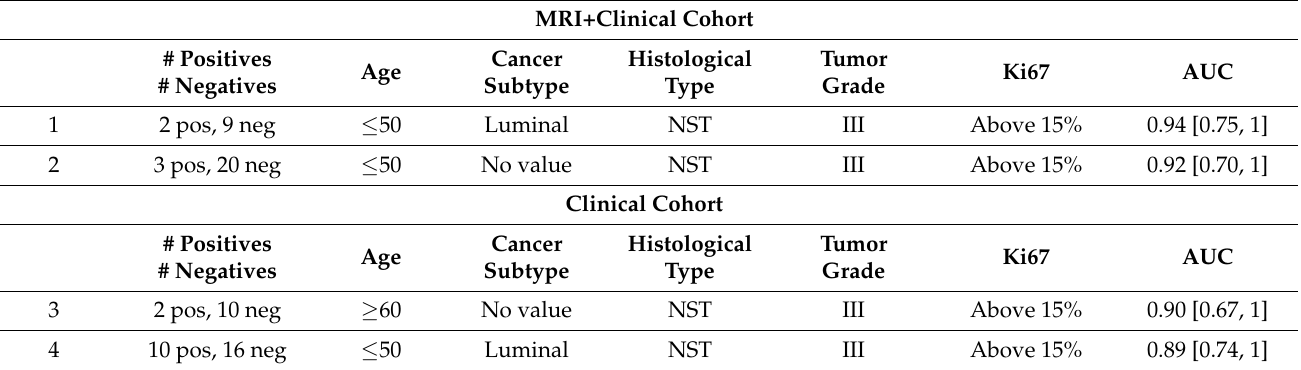
Table 4. Subgroup analysis for both cohorts, the MRI+Clinical cohort and the Clinical cohort. MRI+Clinical